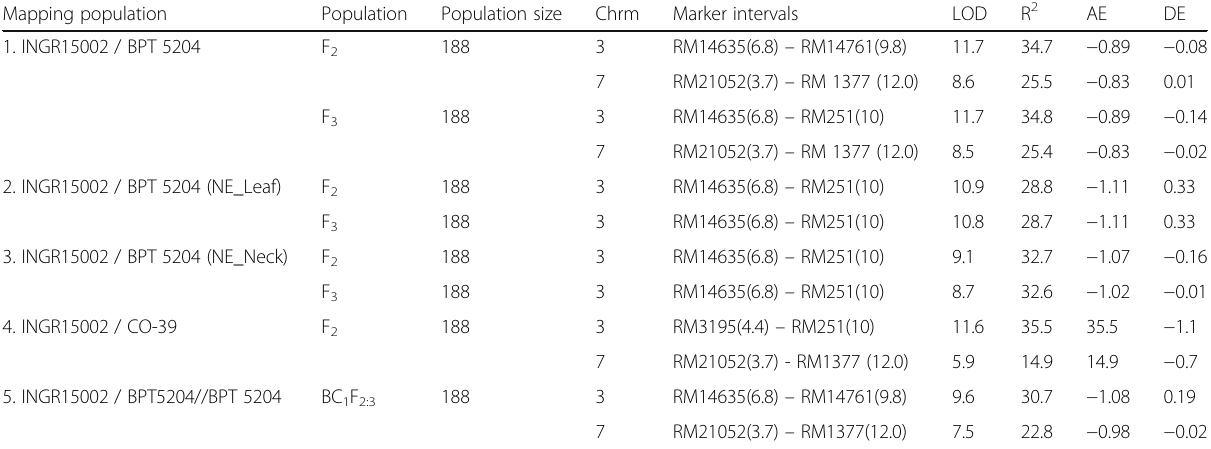
Table 1 Summary of QTLs identified across different mapping populations with ICIM software Mapping population Population Population size Chrm Marker